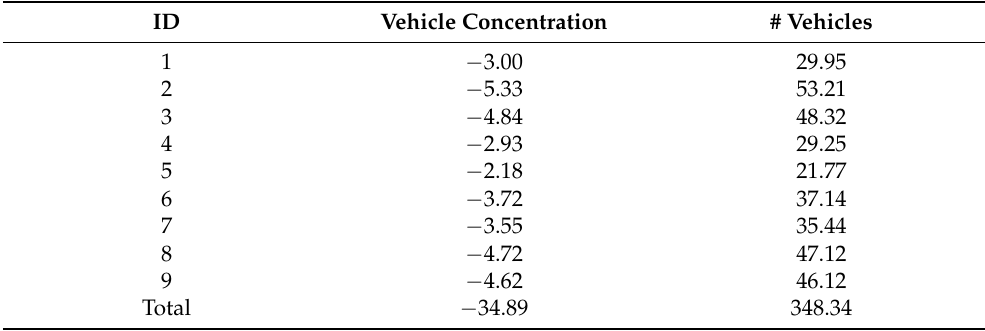
Table 7. Case B: Maximum partial demand in each CS with 9984 km of road network in contingency